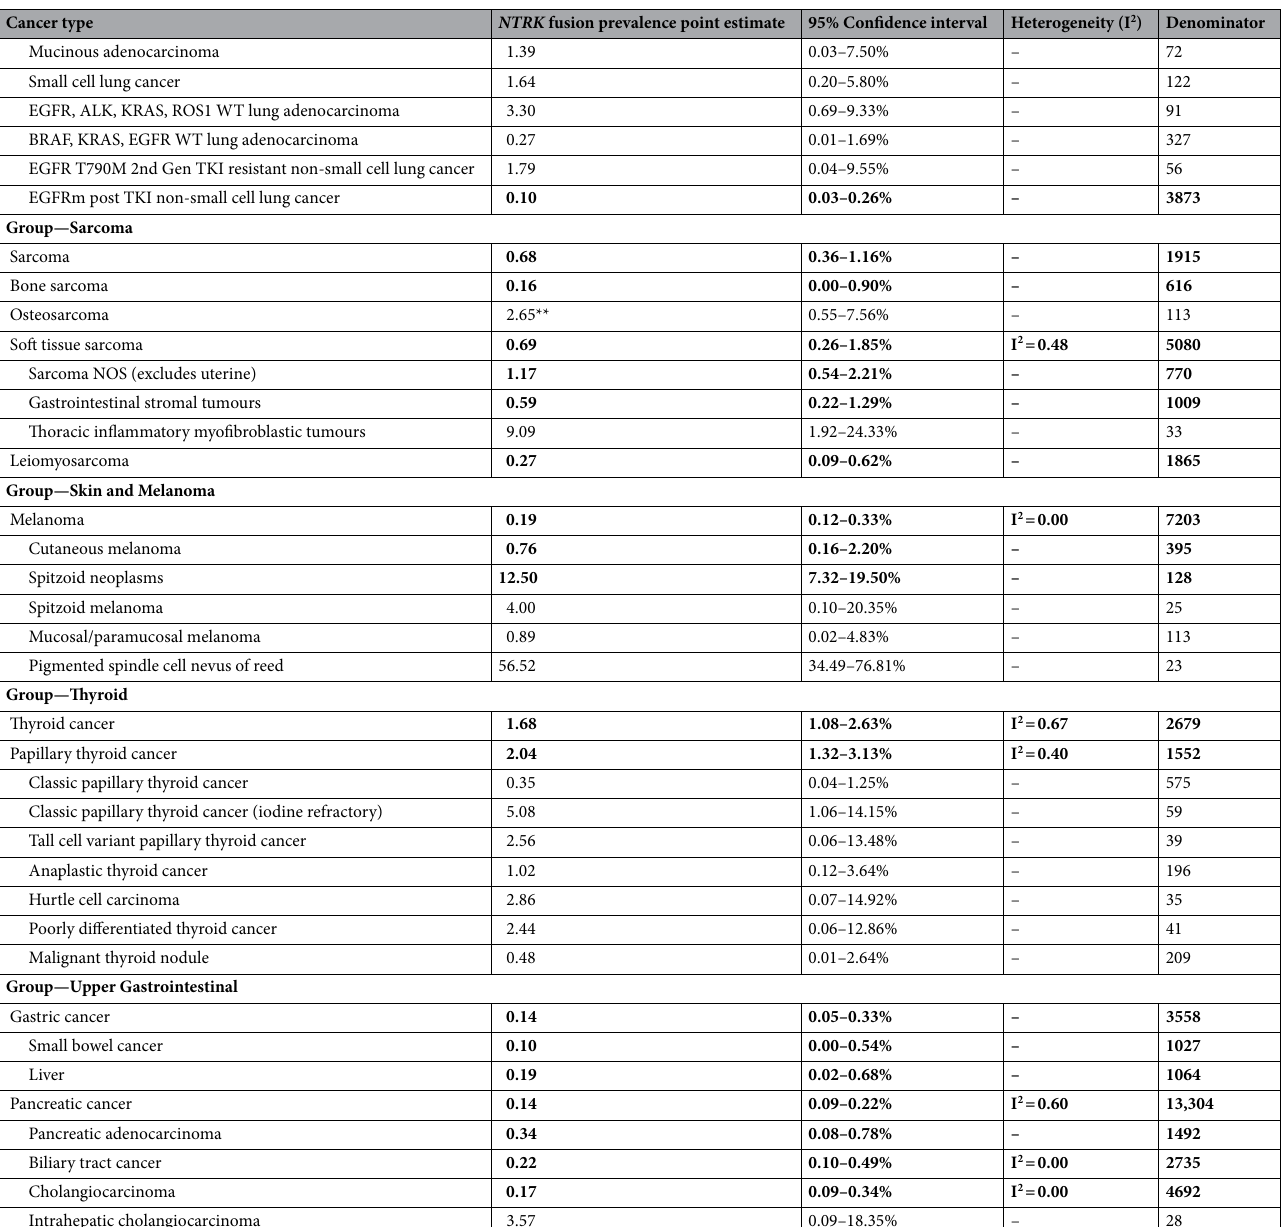
Table 1. Summary of studies, rates and synthesis by cancer group and type. ALK anaplastic lymphoma kinase, BRAF v-Raf murine sarcoma viral oncogene homolog B, CNS central nervous system, EGFR